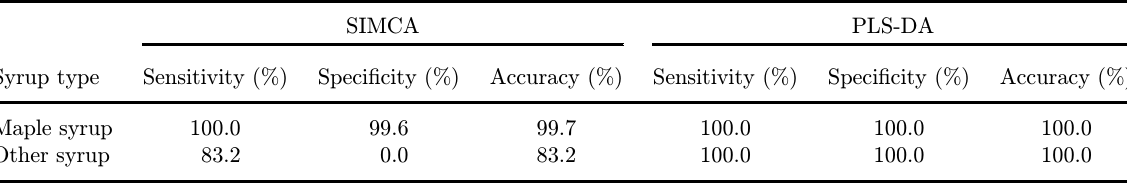
Table 3. Results of discrimination maple syrup from other syrup types using SIMCA and